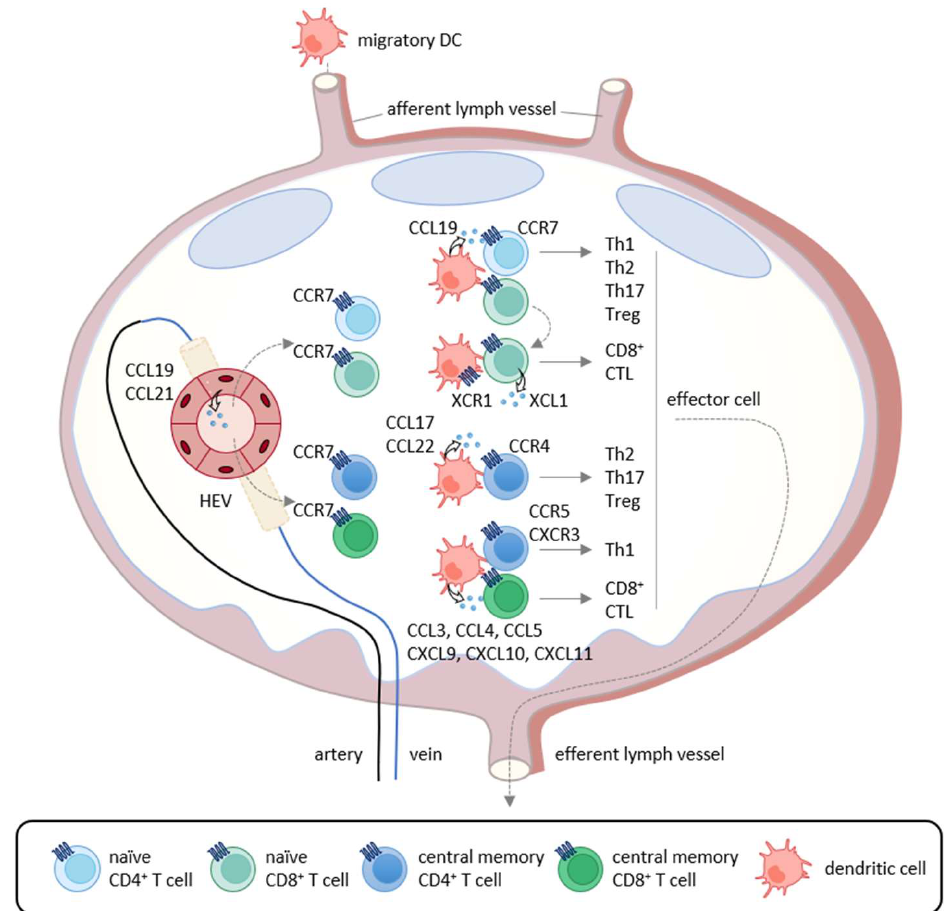
Figure 1. Chemokine-mediated T cell immune responses in the lymph node. In primary immune responses, antigen-captured DCs migrate into the draining lymph nodes via afferent lymphatics using the CCL19/CCL21-CCR7 axis. In the lymph nodes, mature DCs produce CCL19 and interact with recirculating CCR7-expressing naïve CD4 + T cells that home into the lymph nodes via the high endothelial venules (HEVs). If stimulated by cognate antigenic peptides presented by mature DCs, naïve T cells differentiate into Th1 cells, Th2 cells, Th17 cells, and Treg cells according to the local cytokine milieu.